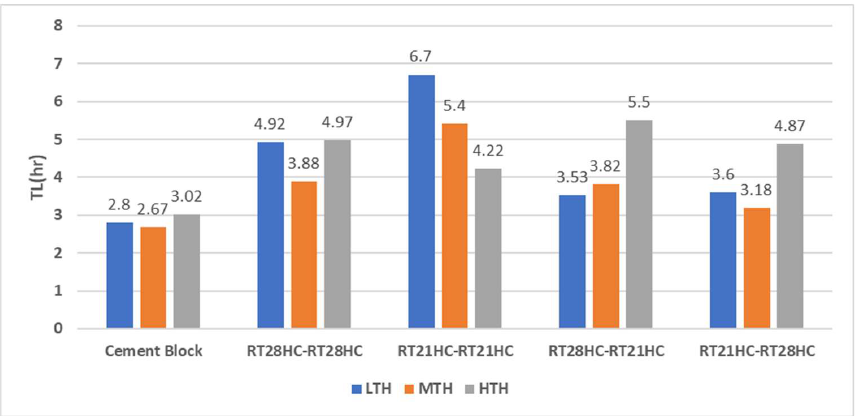
Figure 17. TL values for cement-block-only samples and samples with integrated PCMs.